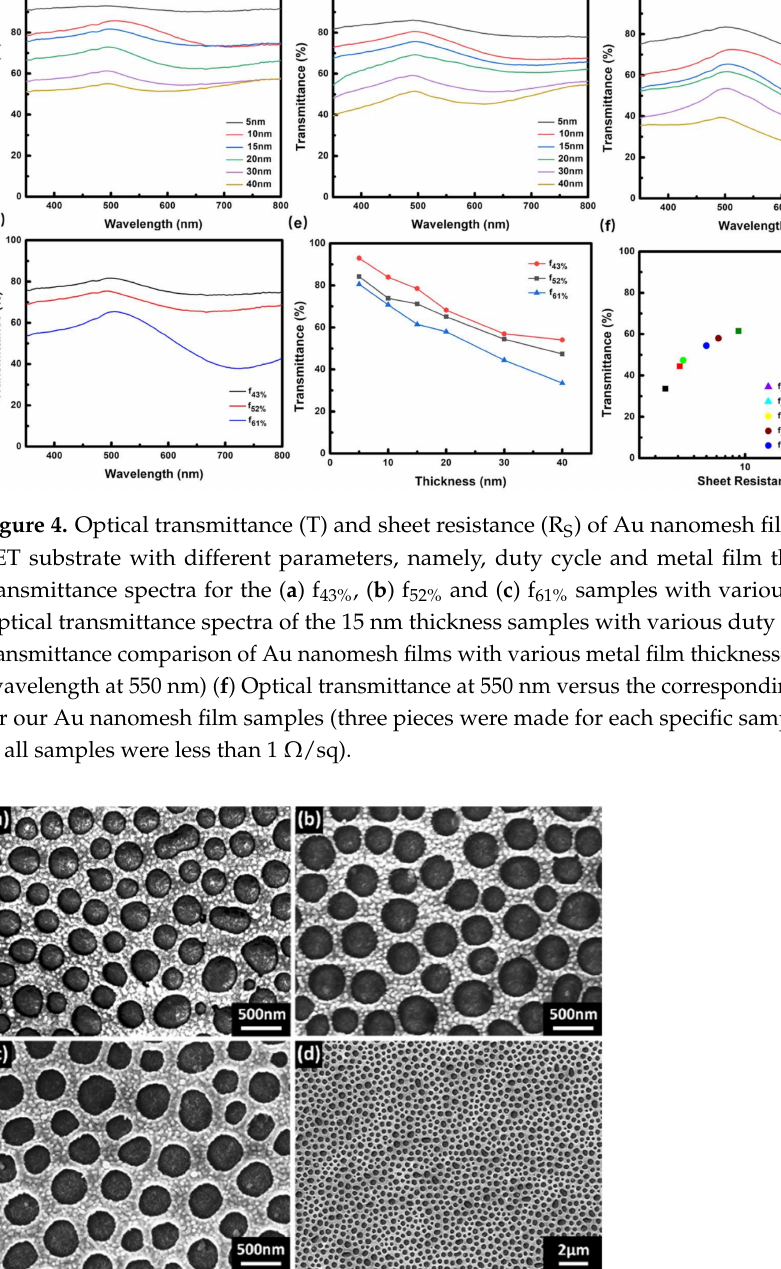
Figure 5. SEM images of our Ag nanomesh film samples ( a ) 1, ( b ) 2, and ( c ) 3. ( d ) SEM image of large-area Ag nanomesh film sample 3 at low